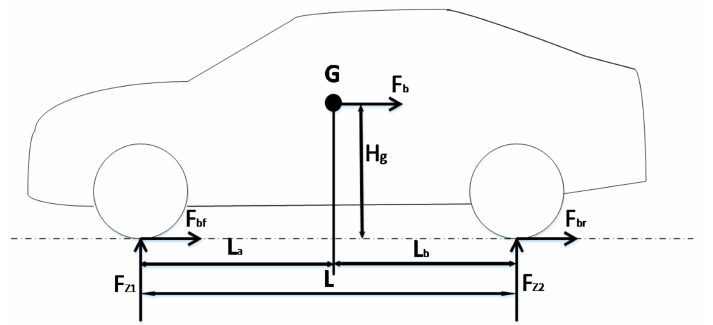
Figure 7. Wheel load analysis when braking on a flat